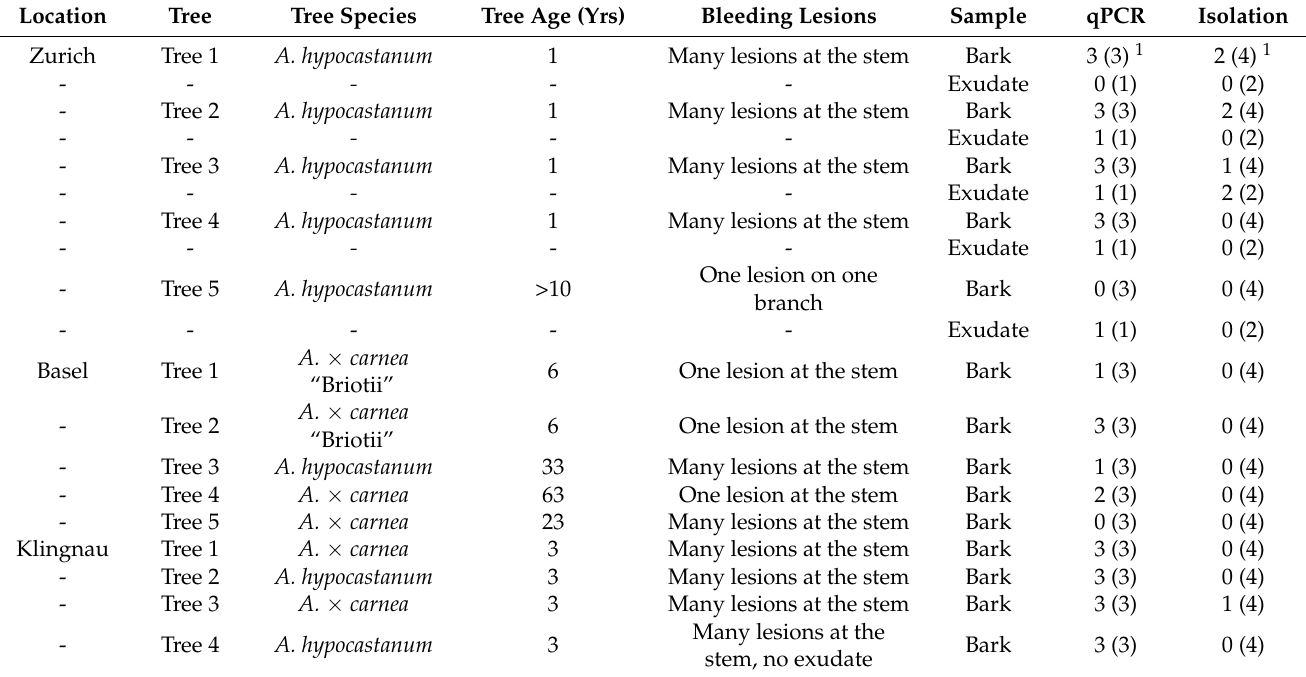
Table 1. Detection of Pseudomonas syringae pv. aesculi (PSA) in bark and exudate samples collected from bleeding lesions on Aescculus spp. by quantitative PCR (qPCR) and isolation. A tree was considered to be infected by PSA if at least one sample tested positive for PSA by qPCR or